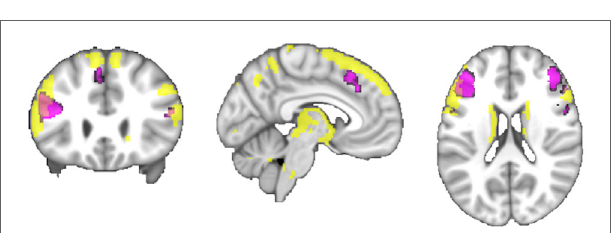
FigUre 6 | a comparison of the conjunction across rs-Fc, MacM, and sc (purple) with brain regions found to be significantly connected with the seed region when using PT (yellow) at p < 0.05, FWe corrected for multiple comparisons using threshold-free cluster enhancement (TFce statistic) .